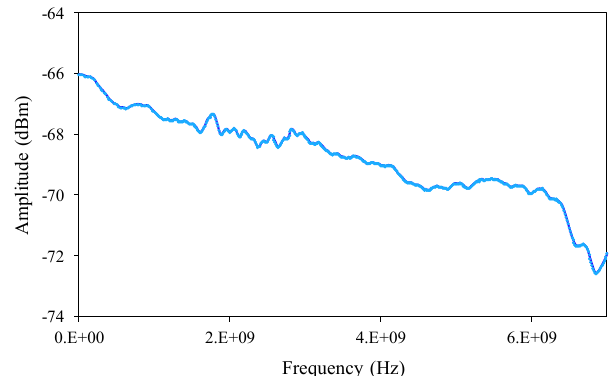
Figure 3. The characterized electrical spectrum response from ESA.